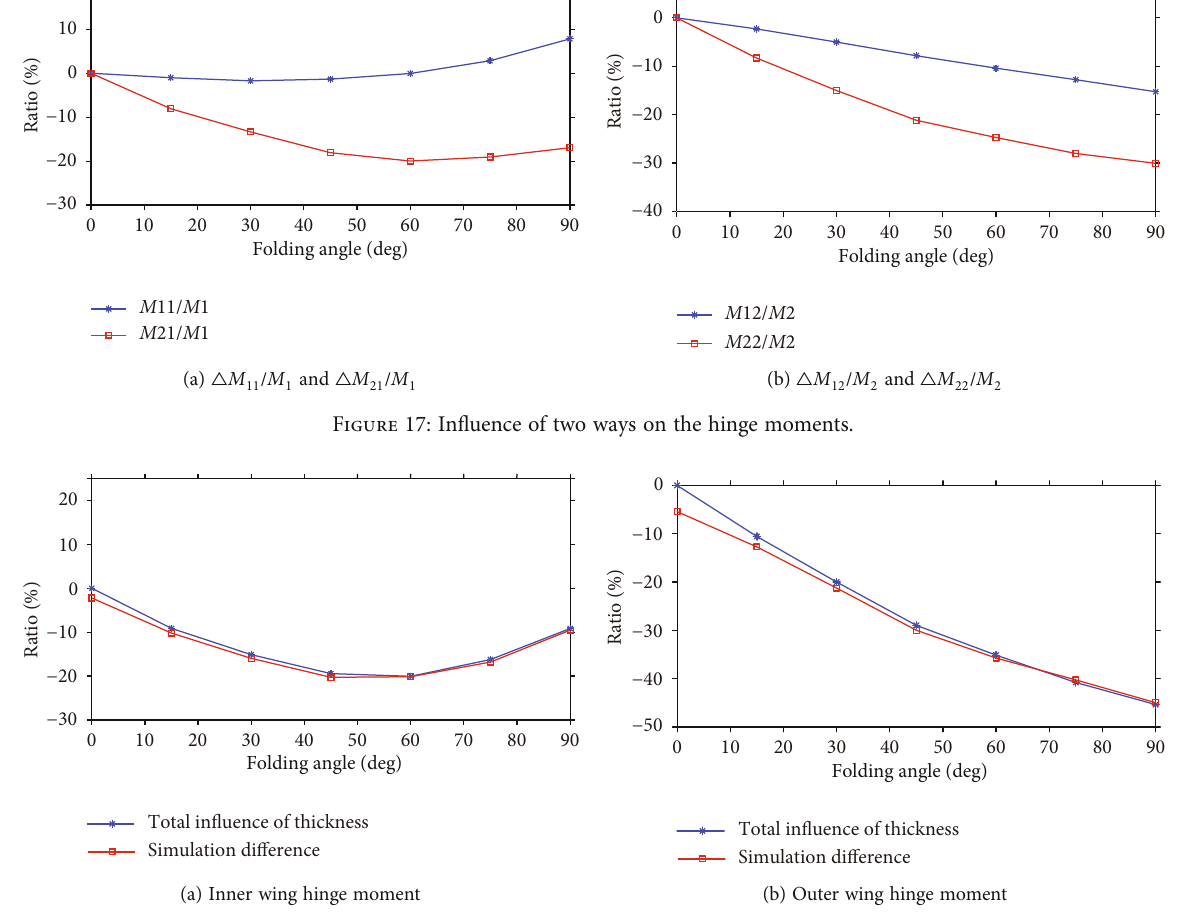
Figure 18: Comparison of simulation di ff erences and thickness e ff